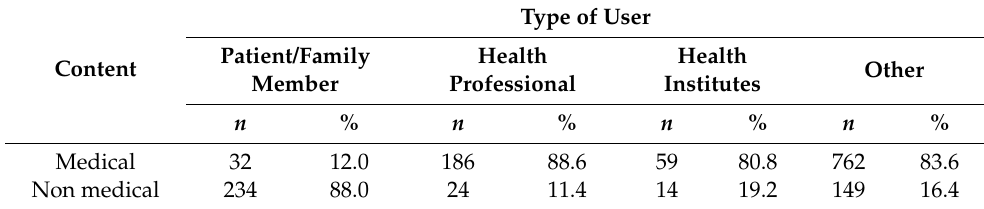
Table 5. Medical vs. non-medical content by type of Twitter